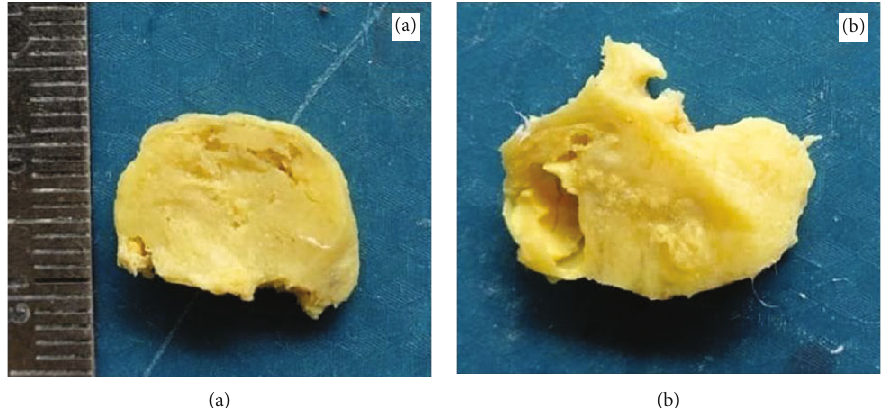
Figure 5: (a, b) Grossing image shows solid mature tissue areas.